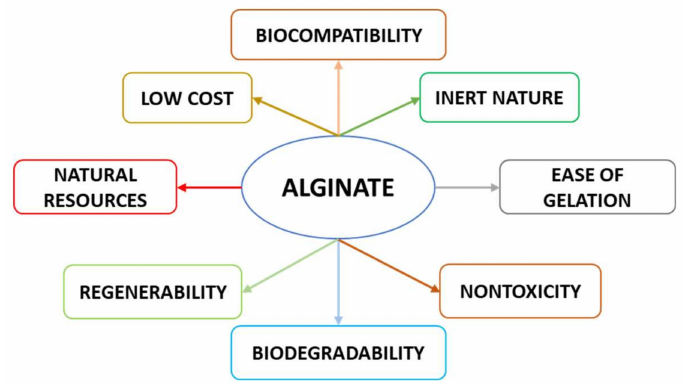
Figure 1. Advantages of